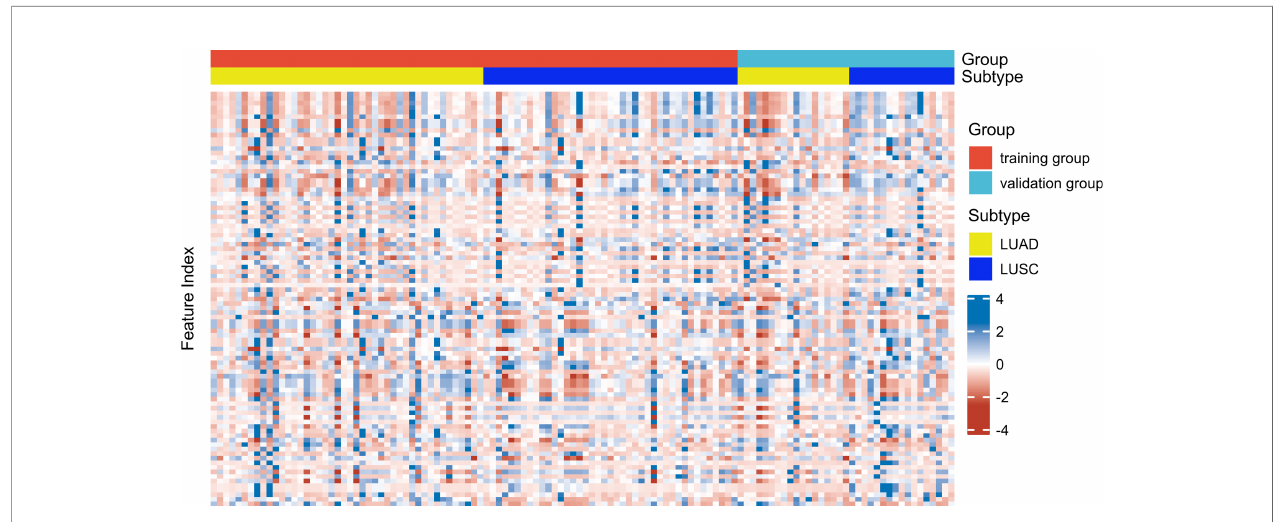
FIGURE 1 | Heatmap of 91 radiomic features (in columns) distributed in the training group (n = 85) and (in rows) distributed in the validation group (n =